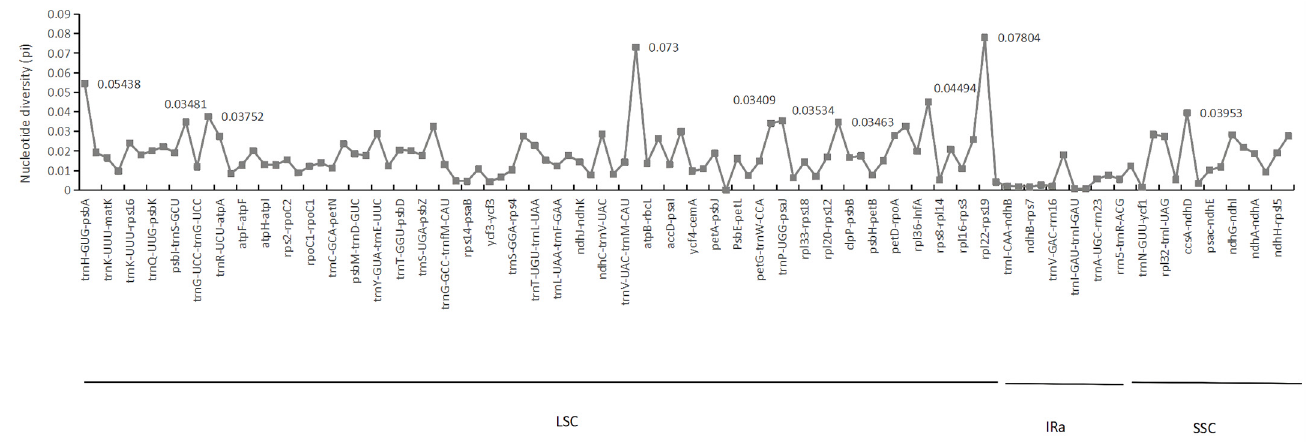
Figure 5. The nucleotide diversity ( π ) of noncoding regions among the seven Euonymus species. In addition to nucleotide mutations, insertions/deletions (indels) are another common type of genetic variation in cp genomes. Sixty-five indels were detected in the two